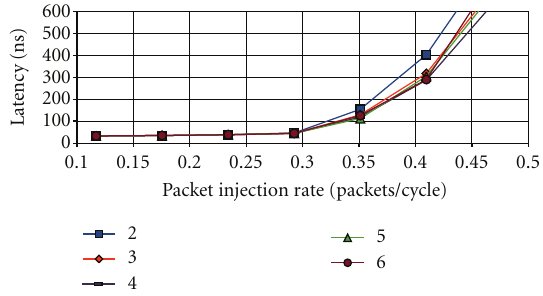
Figure 13: Latency as number of virtual channels is varied for ami49